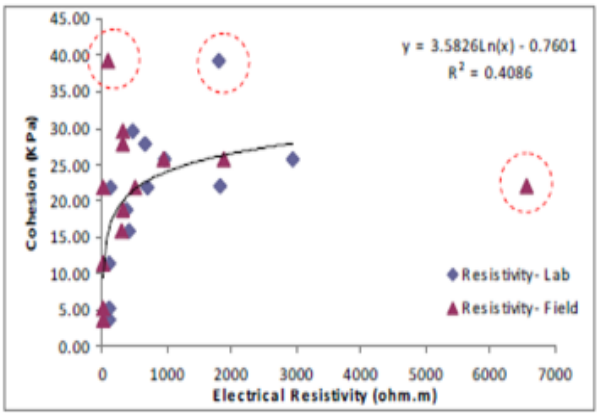
Fig. 6. Relationship between ER and cohesion